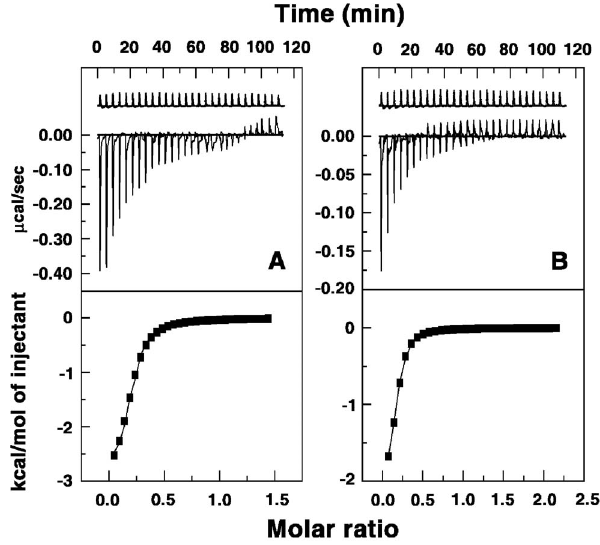
Figure 6. Representative ITC profiles for the complexation of the berberine analogs to tRNA. The profiles shown represent the sequential titration of successive aliquots of analogs (A) B2 and (B) B4 to tRNA (curve at the bottom), along with the dilution profiles (curves on the top offset for clarity). The top panel represents the raw data and the bottom panel shows the integrated heat data after correction of the heat of dilution. The symbols ( & ) represent the data points that were fitted to a one-site model and the solid lines represent the best-fit data.